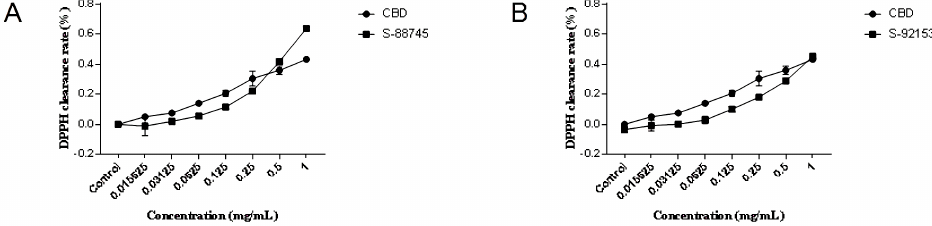
Figure 2. The graph of DPPH scavenging ability. ( A ) The DPPH scavenging abilities of CBD and its skeleton derivative, S-88745. ( B ) The DPPH scavenging ability of CBD and its skeleton derivative, S-92153. The control group was not treated with CBD, S-88745 and S-92153, and only contained DPPH solution. The experiments were repeated three times. Each bar illustrates the average ± standard deviation (SD) counted from three experiments.